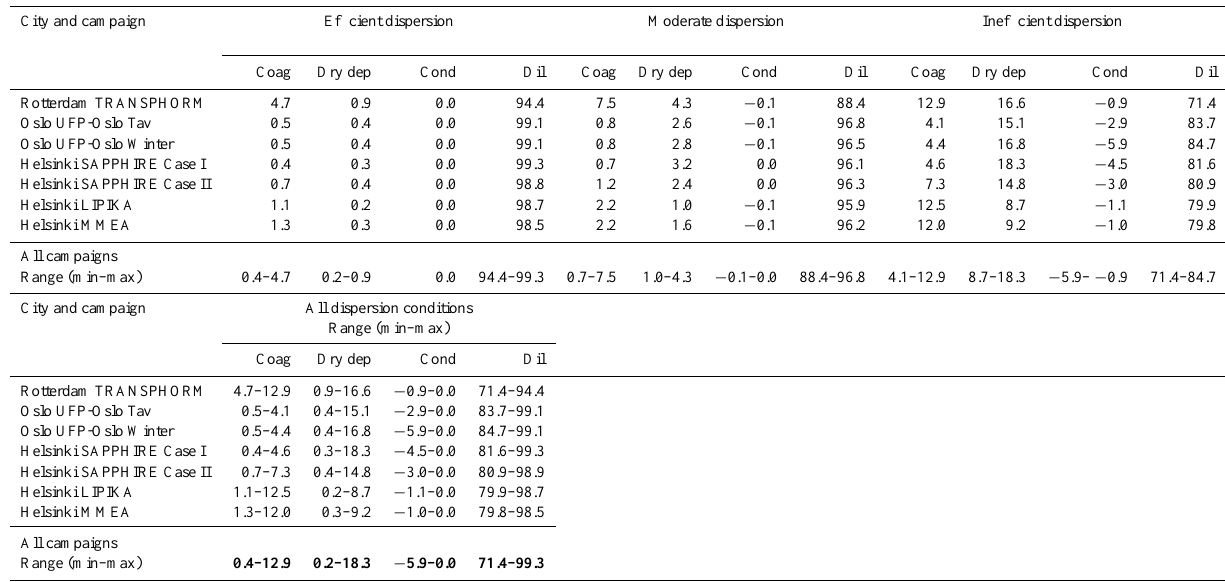
Table 4. Contribution of processes coagulation (Coag), dry deposition (Dry dep), condensation (Cond) and dilution (Dil) to change of PN concentration (%) between roadside station and neighborhood environment after 30min transport time for different dispersion conditions (i.e., ( (cid:49) PN process / (PN(initial) − PN(end))) × 100%; with (cid:49) PN process being the change due to the respective process after 30min). Values in bold denote the range (minimum to maximum) of PN changes (%) for all campaigns and dispersion conditions. City and campaign Efficient dispersion Moderate dispersion Inefficient dispersion